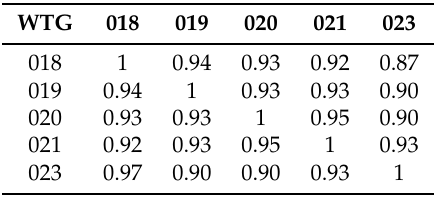
Table 2. Matrix of model input variables correlation coefficients.